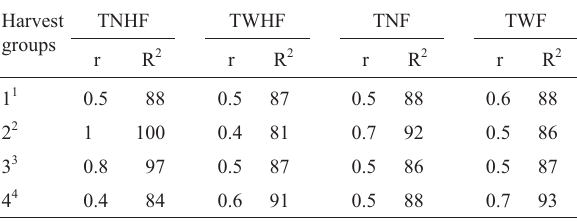
Table 3 - Repeatability coefficients (r) and coefficients of determination (R 2 ) for four groups of six harvests, for total number of healthy fruit per plant (TNHF), total weight of healthy fruit per plant (TWHF), total number of fruit (TNF) and total weight of fruit (TWF) obtained from genotypic data for 34 tomato